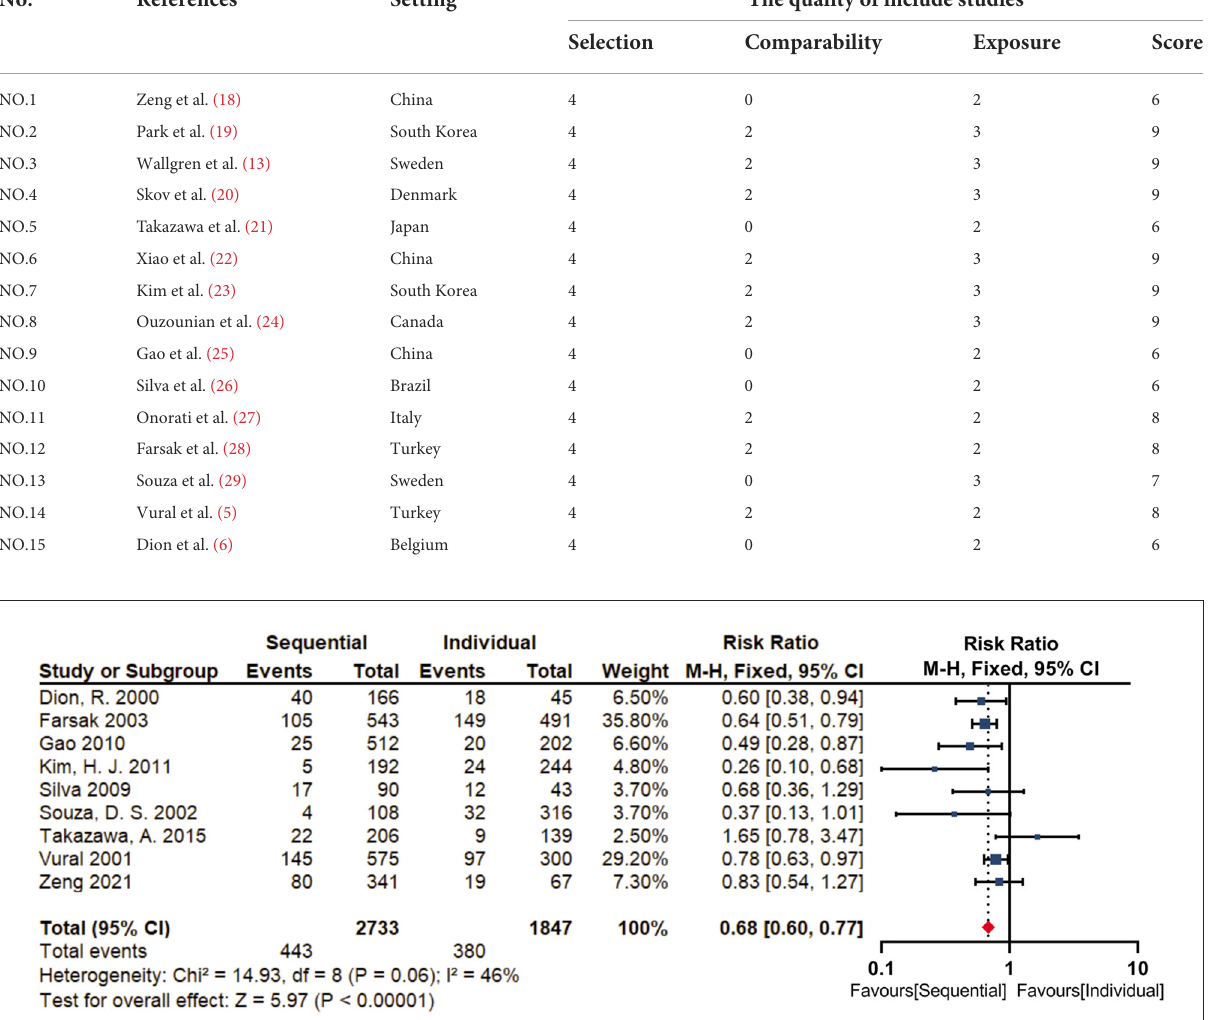
Eight studies reported on the evaluation methods of grafts, of which two were examined by CT and six were assessed by angiography (Supplementary Figure S1A). Subgroup analyses found that there was high statistical heterogeneity between CT subgroup and angiography subgroup in our meta-analysis results (I 2 = 78.1%, P = 0.03). In CT subgroup with a low statistical heterogeneity (I 2 = 22%, P = 0.26), graft failure rate was 4.3% in sequential group vs. 9.7% in individual group (RR = 0.4; 95% CI, 0.24–0.65, P = 0.0002). In angiography subgroup with no statistical heterogeneity (I 2 = 0%, P = 0.51), graft failure rate was 21.4% in sequential group vs. 25.9% in individual group (RR = 0.69; 95% CI, 0.60–0.79, P < 0.001). Subgroup analyses